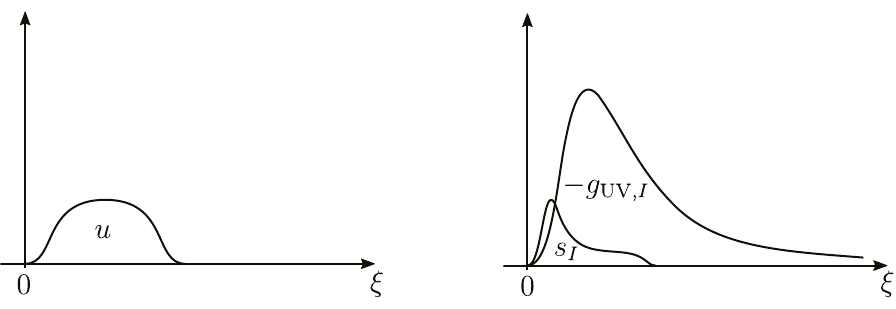
Figure 3 . Cartoon of the window function u dressing UV perturbations (left) and the response δg = g UV ,I to a UV perturbation s I (right) as a function of ξ = ln( K c (1 K c ) − 1 s . Taking the perturbation source s ( ϕ 1 , ϕ 2 ) − | i